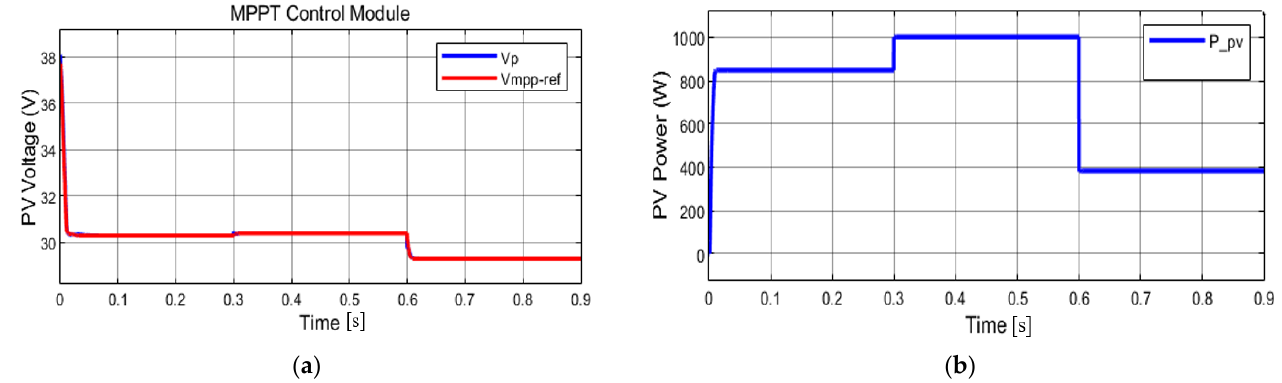
Figure 14. MPPT module performance in case with the backstepping approach for constant temperature: ( a ) PV voltage; ( b ) PV output power.